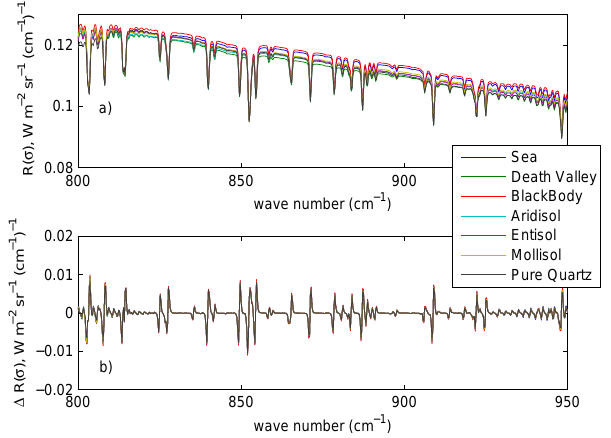
Figure 2. Top panel: radiance spectra in the atmospheric window Fig. 2. Top panel: Radiance spectra in the atmospheric window seg- segment [800–950]cm − 1 for very different surface emissivities. ment [800-950] cm − 1 for very different surface emissivities. Bot- Bottom panel: the same radiance spectra after first-order differentia- tion. The synthetic spectra are based on the same set of atmospheric tom panel: the same radiance spectra after first order differentiation. parameters; only emissivity is changed according to the surface fea- tures listed in the legend.